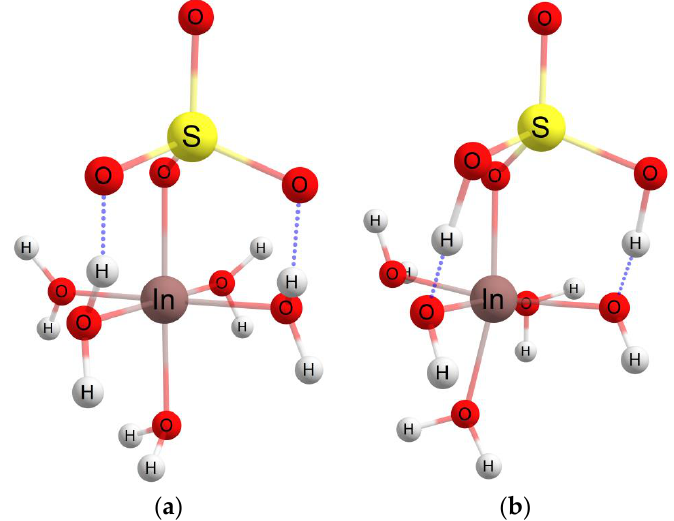
Figure 7. The ideal spatial structure of the In(H 2 O) 5 (SO 4 ) + - ( a ) and In(OH) 2 (H 2 O) 3 (H 2 SO 4 ) + - ( b ) (The blue dotted line illustrates the hydrogen bond type interaction).